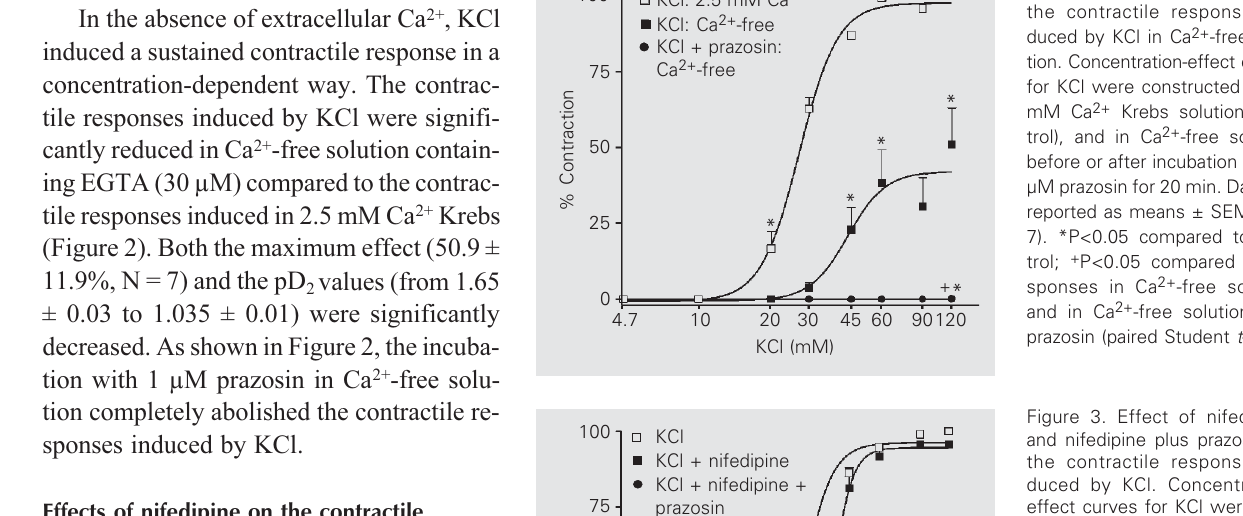
Figure 3. Effect of nifedipine, and nifedipine plus prazosin on the contractile responses in- duced by KCl. Concentration- effect curves for KCl were con- structed before and after incu- bation with 1 µM nifedipine for 20 min, or with 1 µM nifedipine plus 1 µM prazosin for 20 min. Data are reported as means ± SEM (N = 8). *P<0.05 compared to responses in the absence and in the presence of the antago- nists (paired Student t